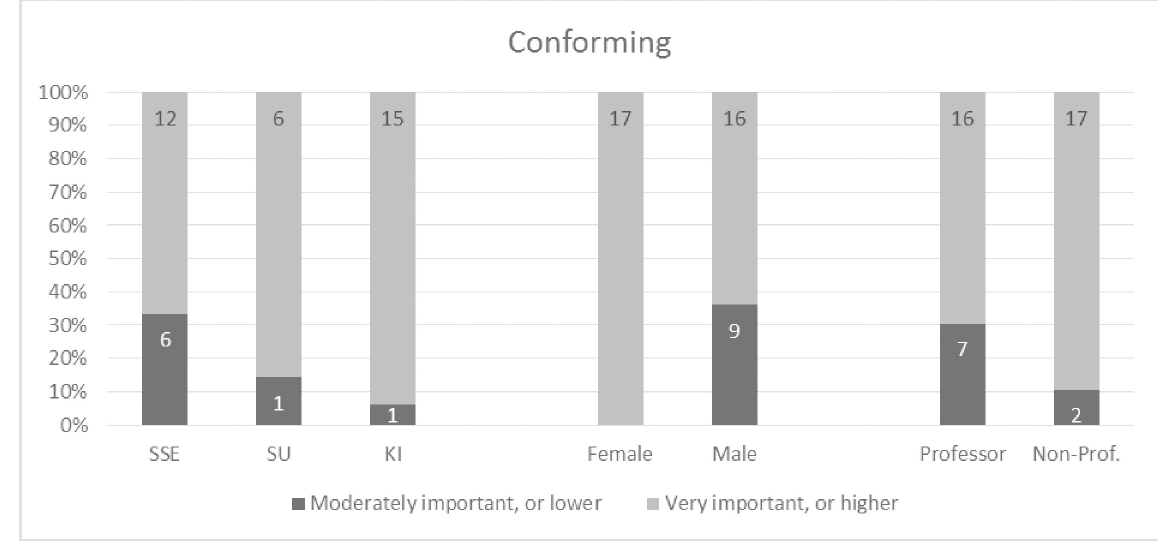
Fig 9. Response rates for conforming between universities, gender and academic level.